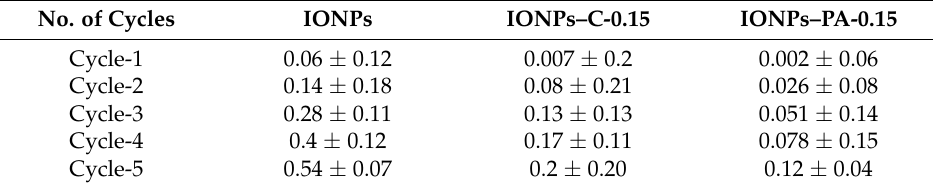
Table 4. Ion release from adsorbents after adsorption and desorption cycles (mg/L).